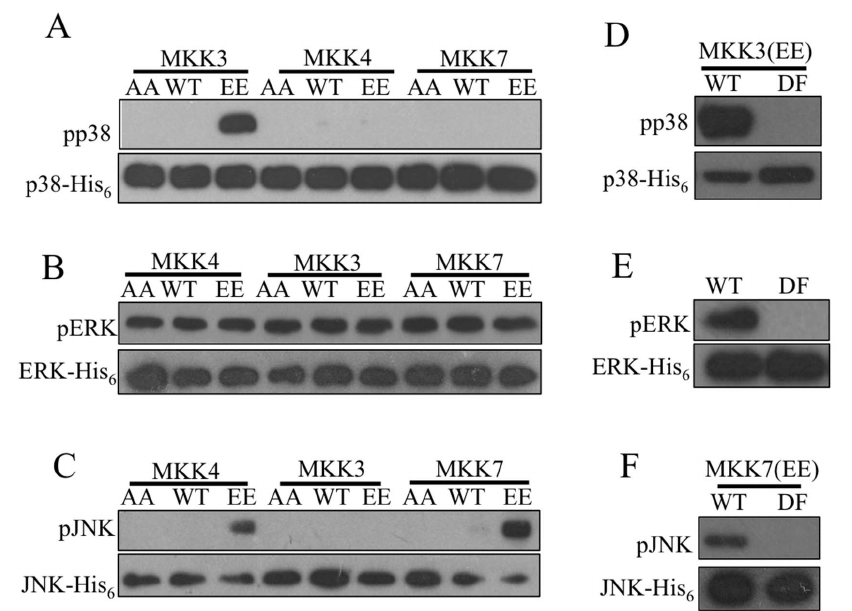
Figure 3. MKK3 specifically phosphorylated p38MAPK. Constitutively activated or inactivated MKKs were constructed by replacing the dual phosphorylation sites with Glu and Ala, respectively. Phosphorylation-defective mutations of MAPKs were constructed by substituting the Thr-X-Tyr motif with Ala-X-Phe. MKKs and MAPKs were expressed in E. coli with a GST or His 6 tag, respectively, and used for kinase assays. (A) Constitutively activated MKK3 effectively phosphorylated p38MAPK. (B) None of the MKKs enhanced activation of ERK, as similar intensity of signal was detected in all lanes. (C) Both constitutively activated MKK4 and MKK7 effectively phosphorylated JNK. (D) MKK3 phosphorylated wild type p38MAPK, but not the phosphorylation-defective mutant. (E) In the absence of MKK protein, wild type ERK was auto-phosphorylated, but no signal was detected when the phosphorylation-defective ERK was used. (F) Constitutively activated MKK7 significantly phosphorylated the wild type form of JNK but not the phosphorylation-defective form. AA: constitutively inactivated mutation; WT: wild type; EE: constitutively activated mutation; DF: phosphorylation-